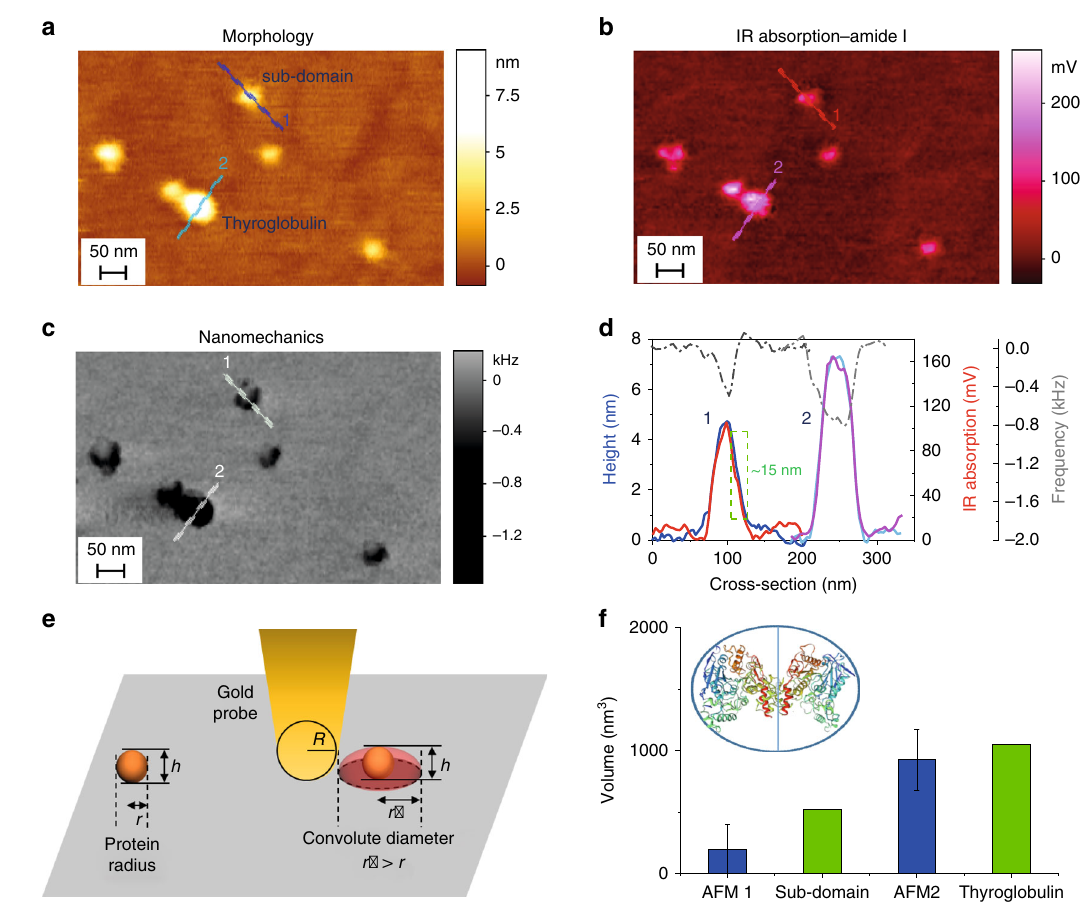
Fig. 2 Simultaneous morphological, chemical and mechanical imaging by IR absorption of single protein molecules. a 3D morphology map of thyroglobulin molecules. b IR absorption image at 1655 cm − 1 (amide band I) and c contact resonance frequency map at 1655 cm − 1 (laser power: 0.24mW; pulse: 100 ns). d Cross-sectional correlation of morphology, IR absorption and nanomechanical properties for the protein species in the map. e An overestimate of the lateral radius r and of the volume of the single proteins in the AFM-IR map is caused by the fi nite geometrical shape and radius of the tip 31,32 . f Inset of the graph is the structure of a thyroglobulin molecule, which is composed by two identical subdomains 29 . We demonstrate single protein sensitivity by comparing the known volumes of a thyroglobulin molecule (blue) and its subdomain (green) 30 , with the deconvoluted volume of each single protein species measured on the surface by AFM (blue, the error on the deconvoluted volume is calculated by varying the radius of the tip between R ~30 and 40 nm) (Supplementary Fig. 6) 31 . The volume of a single protein measured by AFM (blue) is in excellent agreement with the values of the volume of a single subdomain and thyroglobulin. Source data are provided as a Source Data